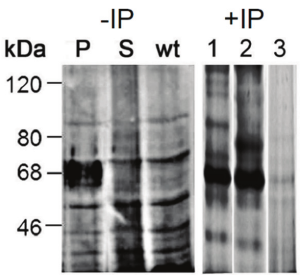
Figure 4. Immunostaining of Western blots with mAb 114-2G11-A (anti-GlcA) of cell lysates from S2-wt and dGlcAT-P (P) or dGlcAT-S (S) overexpressing cells reveals a strong increase of GlcA-epitopes